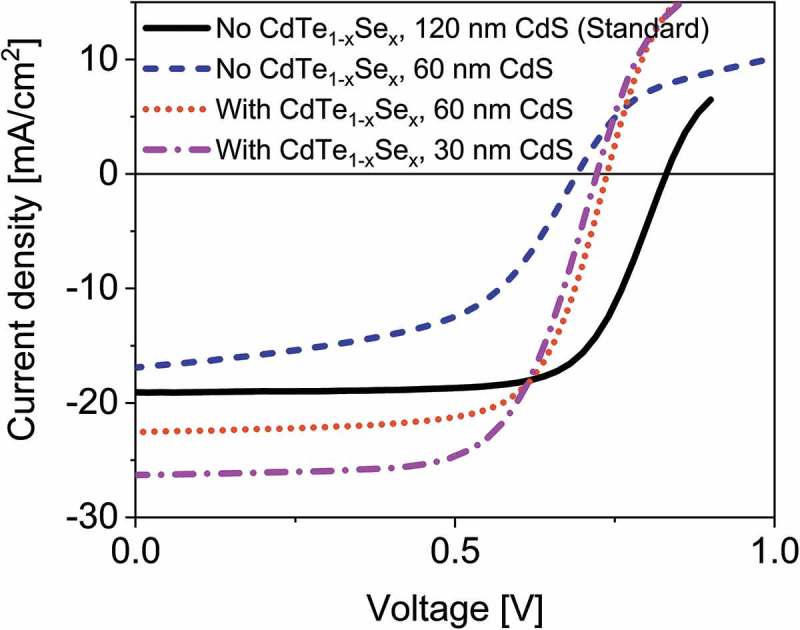
Current-voltage curves of CdTe solar cells with and without CdTe1-xSex grading of the absorber towards the CdS window layer, and with varying CdS window layer thicknesses.